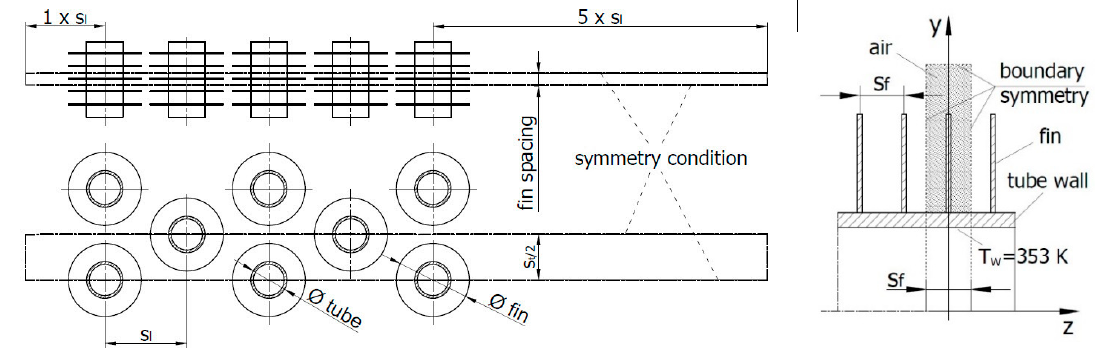
Figure 4. Schematic view of the computational domain.